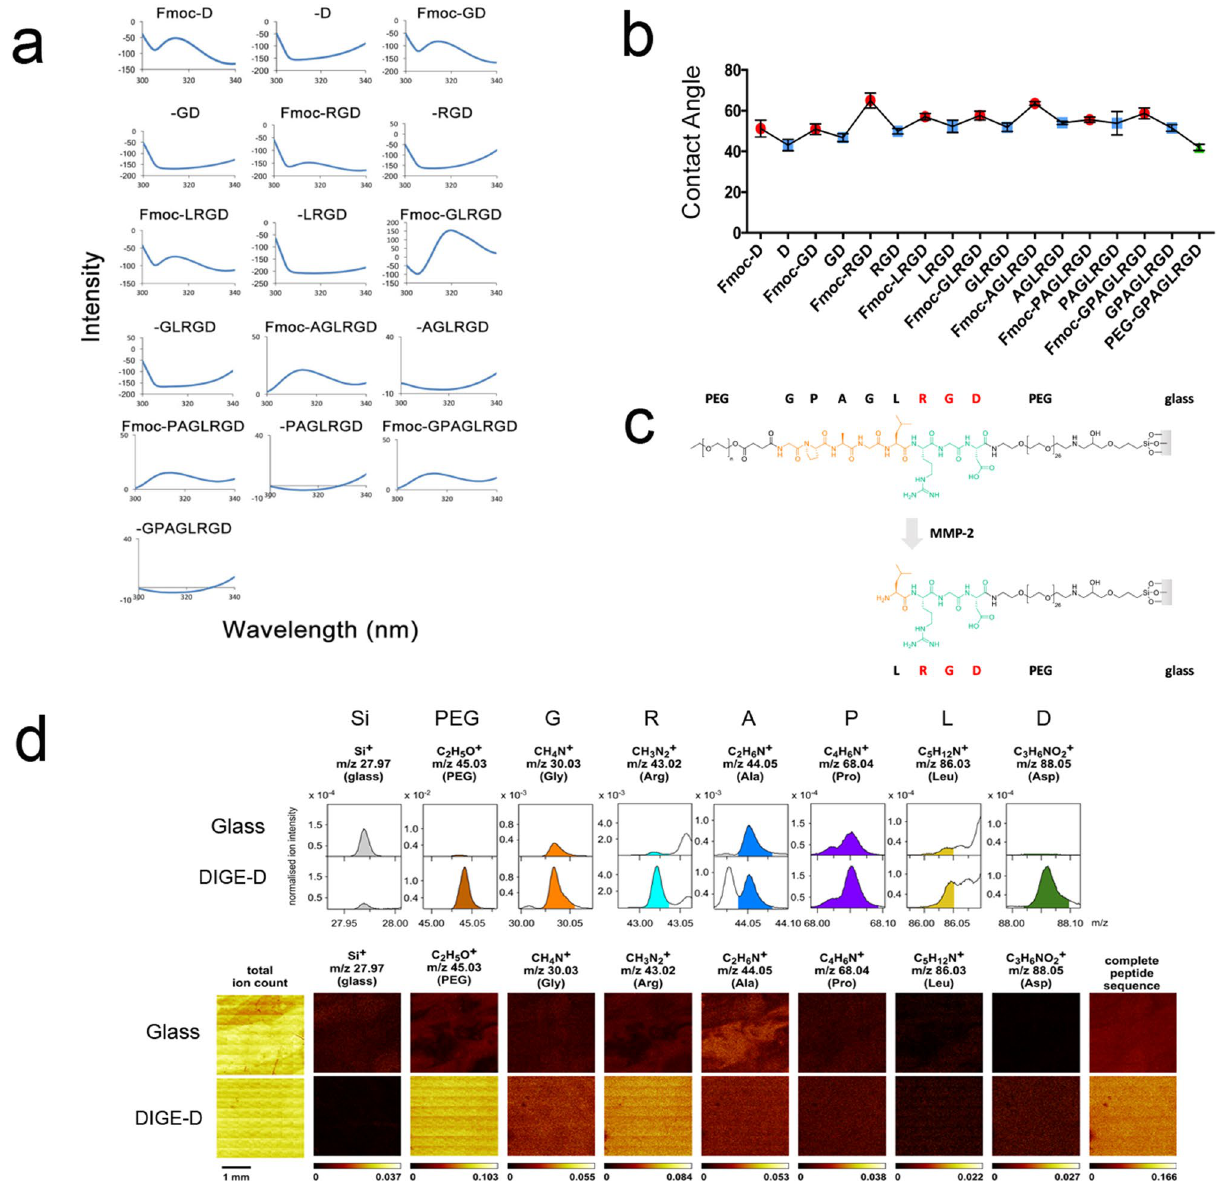
Figure 2. Characterisation of solid-phase peptide synthesis (SPPS) dynamic surface. ( a ) Surface fluorescence spectroscopy following addition/removal of the Fmoc group (Fmoc peak seen at ~ 315 nm) during synthesis. ( b ) Contact angle measurement following addition (red)/removal (blue) of the Fmoc group during synthesis and the final PEG-capped peptide sequence (green) (graph shows mean ± SD, 50 images per dataset with 15 datasets taken across 3 substrates (n = 3)). ( c ) Scheme showing complete RGD surface with MMP cleavable group and PEG blocker before and after MMP cleavage. ( d ) Tof–SIMS data showing that expected amino acids (G, P, A, L, R and D) and PEG were present post-synthesis. Together, this data indicates complete PEG-GPAGLRGD